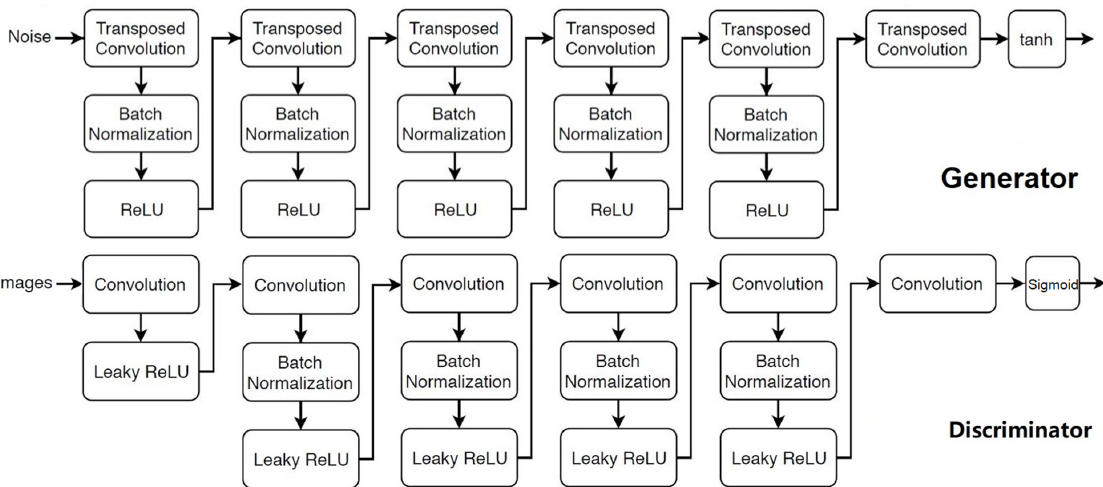
Figure 3. The network architecture of the generator (up) and discriminator (low). The number of filters from the first transposed convolution layer to the last in the generator is 1024, 512,256, 128, 64, 2, respectively. Filter size is 4 by 4 in all layers. The number of filters from the first convolution layer to the last in the discriminator is 64, 128, 256, 512, 1024, and 1. Filter size was 5 by 5 in all layers except in the last convolution layer, which was 4 by